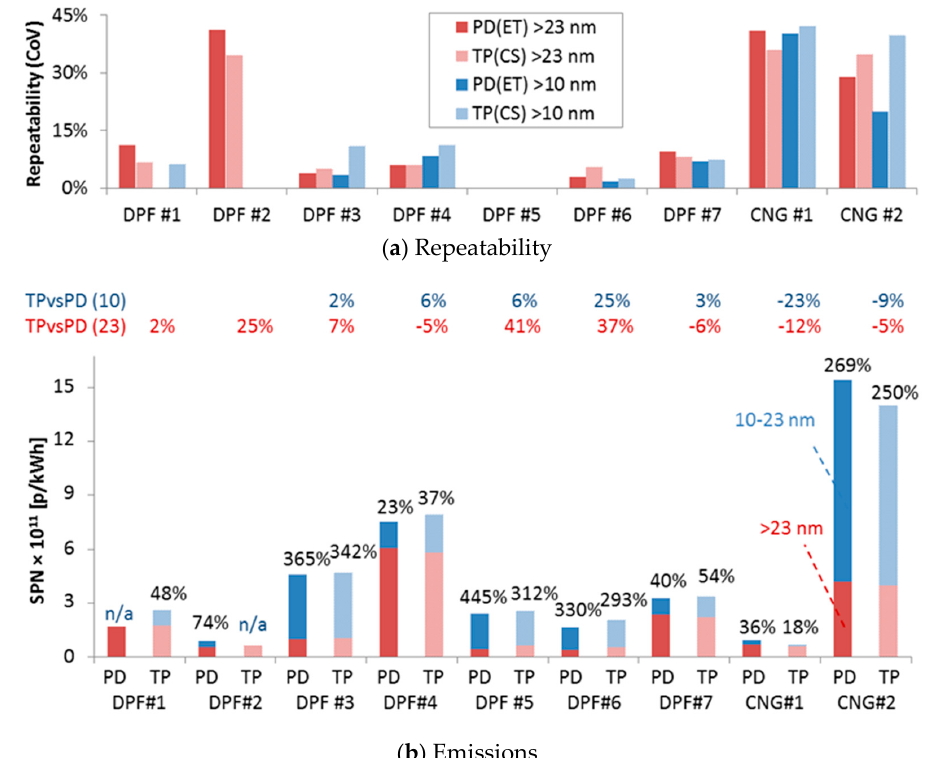
Figure 7. (a) Repeatability, expressed as coefficient of variance (CoV) of 2–3 repetitions, when available. (b) Solid particle number (SPN) emissions given by the laboratories particle system with evaporation tube (ET) connected to the proportional partial flow dilution system (PD) (columns with dark colours) and the “Golden” particle system with catalytic stripper (CS) connected to the tailpipe (TP) (columns with light colours). Emissions >23 nm in red and 10–23 nm in blue. Percentages in black give the 10–23 nm emissions compared to the >23 nm emissions. In the middle, numbers give the differences of the TP system compared to the PD system for the >23 nm and >10 nm emissions.